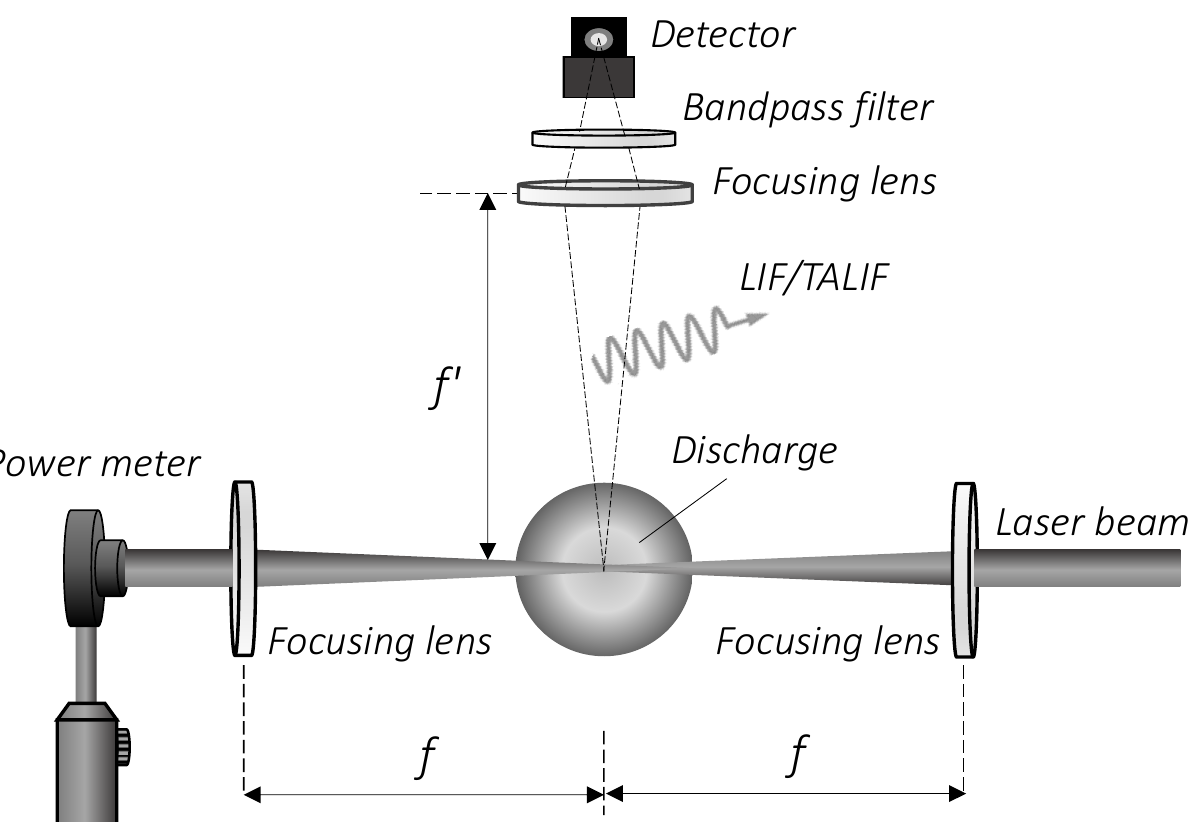
Figure 3. Simplified representation of an experimental arrangement typically used to perform TALIF diagnostics in a gas discharge. Table 1. Excitation schemes and laser characteristics used in different ns – TALIF studies to probe the most common atomic species (H, N and O) in plasmas and flames.